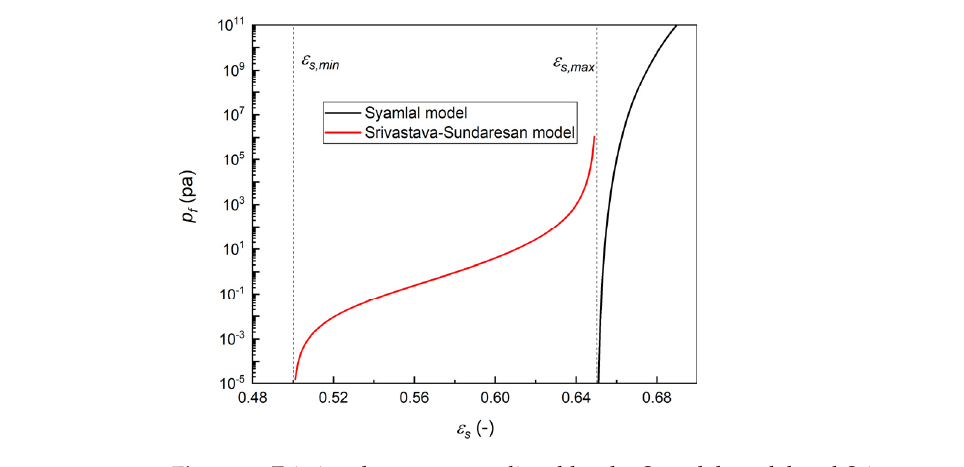
Figure 4. Frictional pressure predicted by the Syamlal model and Srivastava–Sundaresan model, with ε s,min = 0.5 and ε s,max = 0.65.